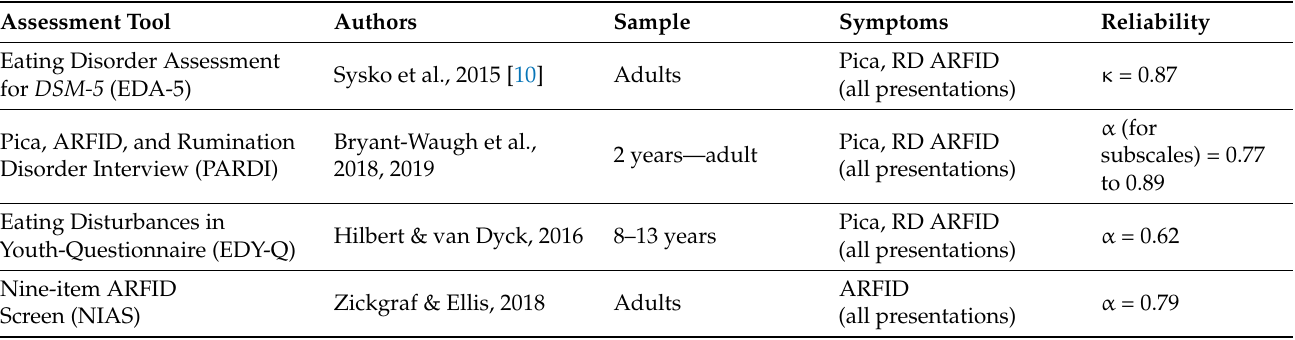
Table 1. Selected tools for the assessment of symptoms of Avoidant/Restrictive Food Intake Disorder (ARFID) and related